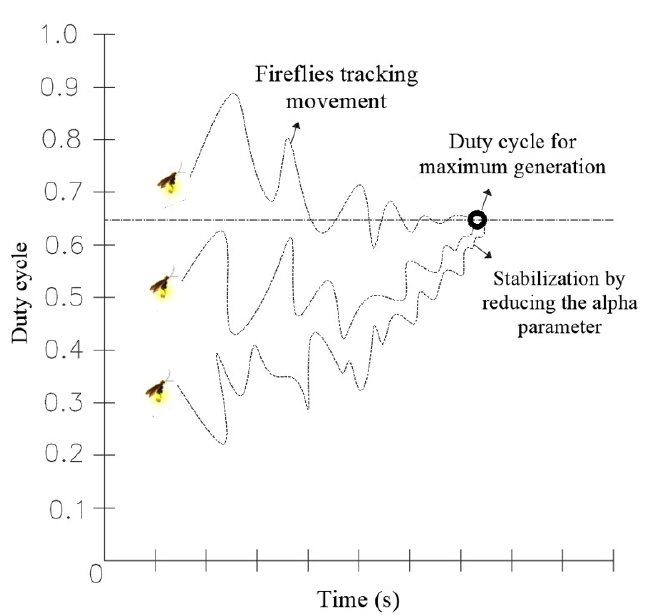
Figure 3. Convergence of fireflies